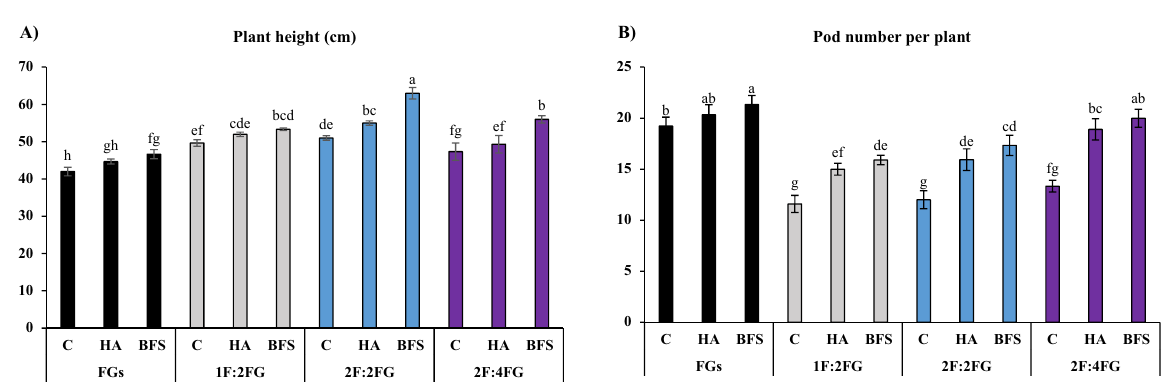
Figure 4. Means comparison for the interaction effect of fertilization [C (control), HA (humic acid), BFS (biofertilizers)] and different cropping patterns [FGs (fenugreek sole cropping), 1F:2FG, 2F:2FG, 2F:4FG (ratios of fennel and fenugreek in the intercropping patterns)] on plant height ( A ) and pod number per plant ( B ) of fenugreek. Different lower-case letters above the bars indicate significant (p ≤ 0.05)